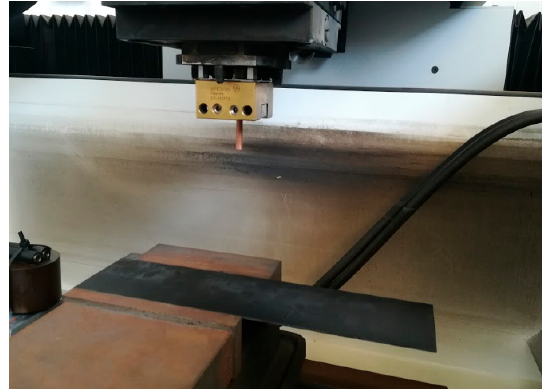
Figure 2. Tool holder positioned in the central column. Table 2. Physicochemical properties of the materials used.